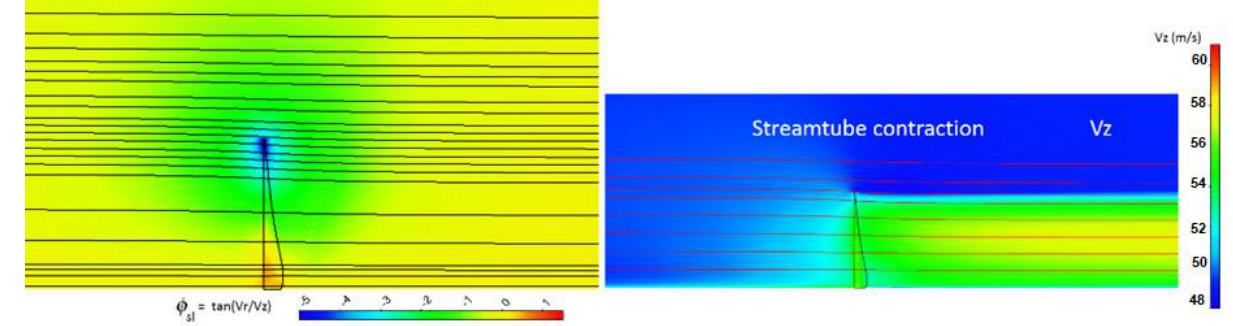
Figure 16. Streamtube contraction in the azimuthal view showing the slope (in degrees) of the streamline (left) and mass-averaged Vz contour plot for 4X domain for the solo propeller.